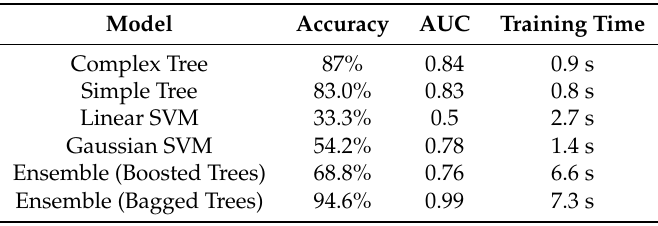
Table 2. Comparison of accuracy, area under the curve (AUC), and training time for different